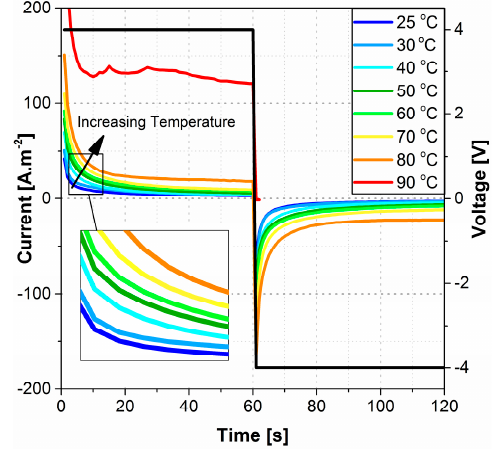
Figure 8. The current flow after applying 4 V across a 1 × 1 cm 2 Nafion membrane with 30% EMI-TF ionic liquid at different temperatures. The leftmost gray line is the current flow at room temperature; each colored line above it shows an increase in temperature from 30 °C to 90 °C.